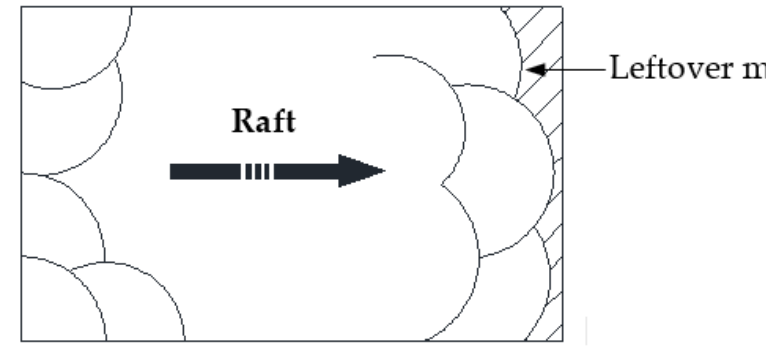
Figure 3. Search central points on the raft from left to right.